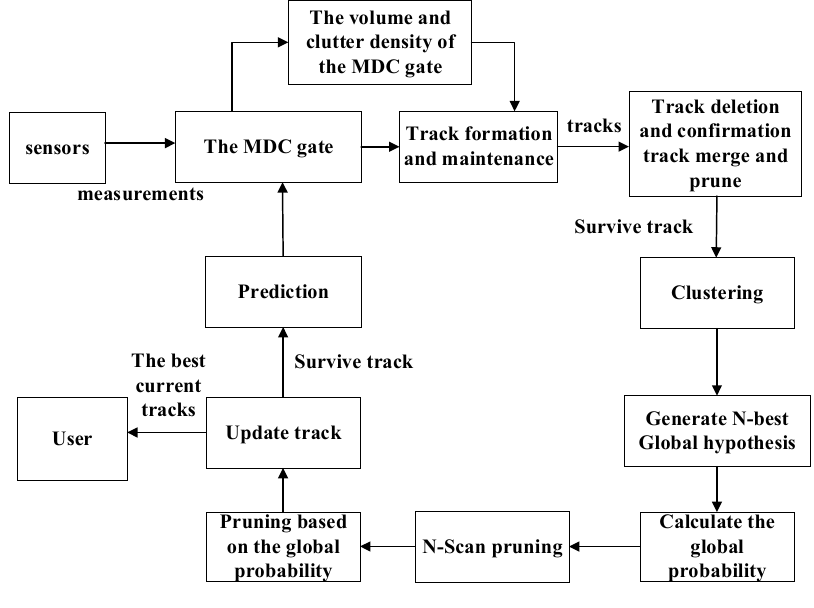
Figure 2. The flowchart of MHT-MDC.